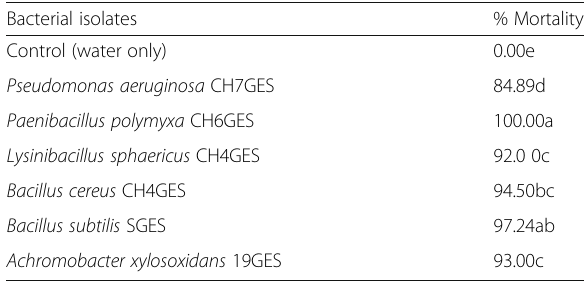
Table 3 Nematicidal activity of culture filtrates of bacterial strains on Meloidogyne incognita juvenile mortality after 48 h Bacterial isolates %